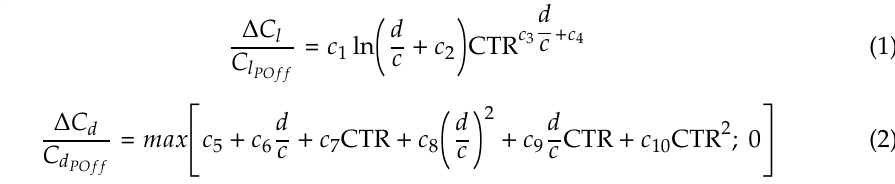
Figure 10. Increment of lift and drag coefficients at α = 8 for d / c = 0.802. In addition, their corresponding tendency lines are dashed.